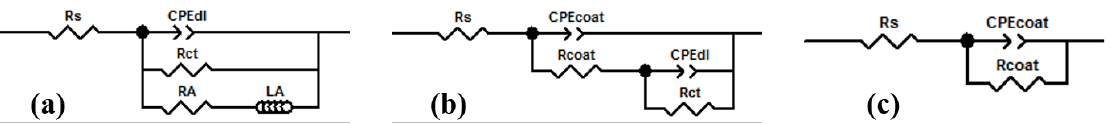
Table 1. The fitting results of EIS shown in Figure 1a.